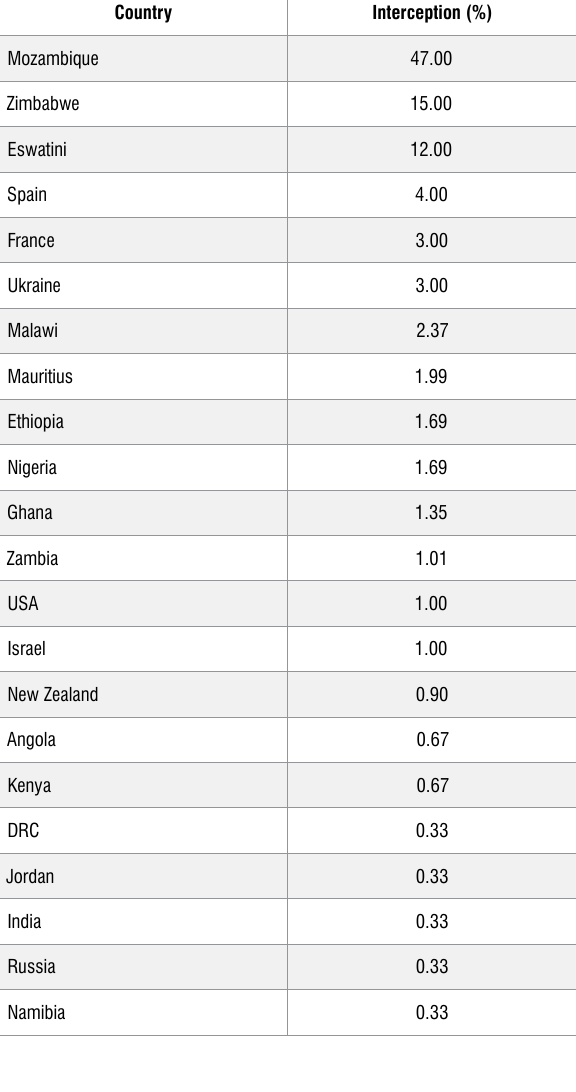
Table 3: Recorded pest interceptions into South Africa by country, 2011–2019 ( n =341) Country Interception